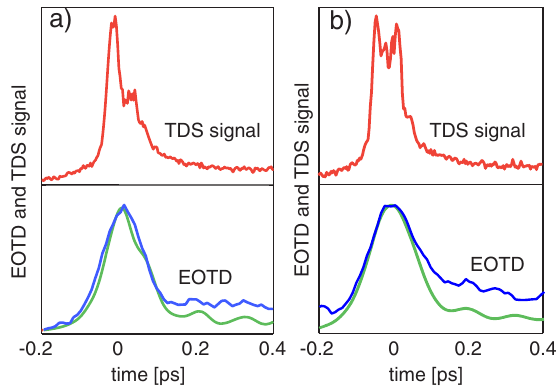
FIG. 14. (Color) Two longitudinal bunch charge profiles mea- sured during FEL operation with the transverse-deflecting struc- ture (TDS), compared to the bunch electric field profiles obtained by single-shot electro-optic temporal decoding (EOTD) using 65 (cid:1) m GaP. The bunch head is at the left side. Only 600 fs of each measurement is shown. The full time window is 2 ps for the TDS measurement and 12 ps for the EOTD measurement. The simulated EO signal (green) has been calculated from the TDS